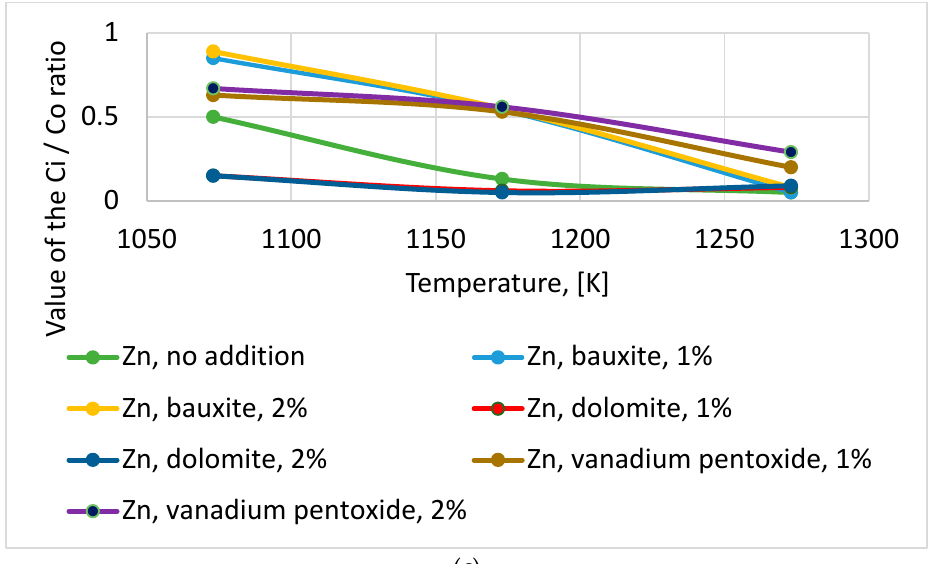
Figure 6. Dependence of the Ci/Co value on the sewage sludge combustion temperature: ( a ) cadmium, ( b ) copper, ( c ) zinc.